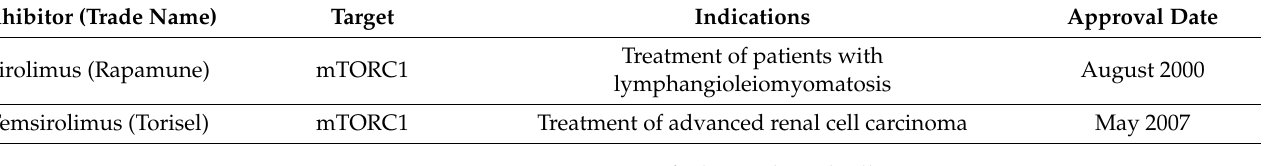
Table 7. Allosteric mTOR inhibitors approved by the Food and Drug Administration (FDA) for human cancers. Inhibitor (Trade Name) Target